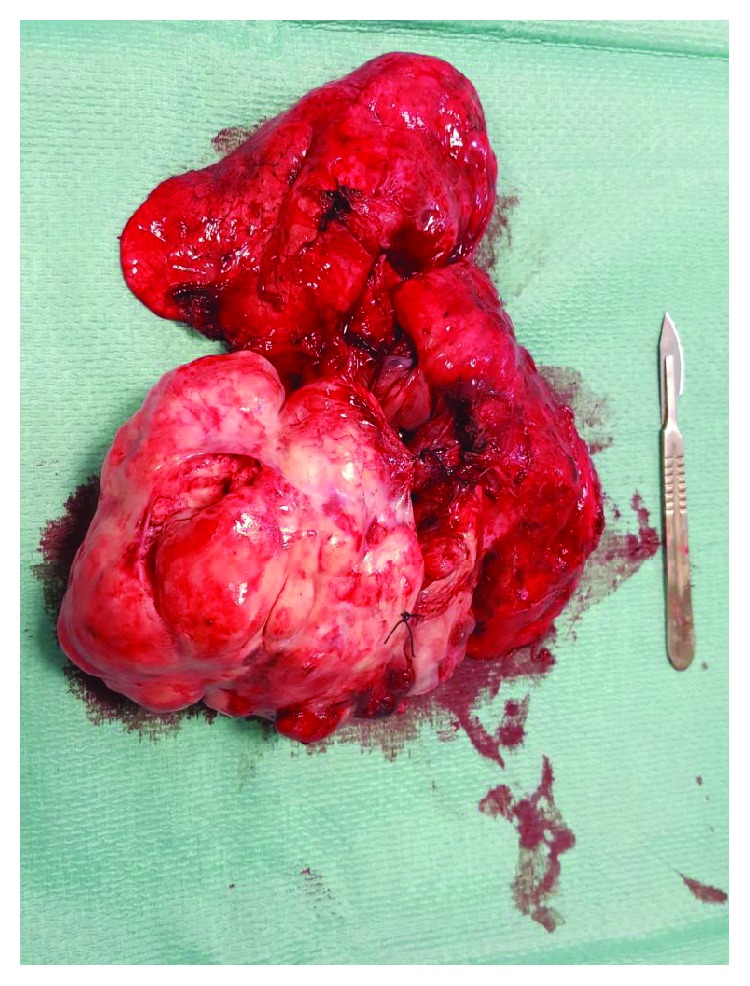
Pneumonectomy piece.